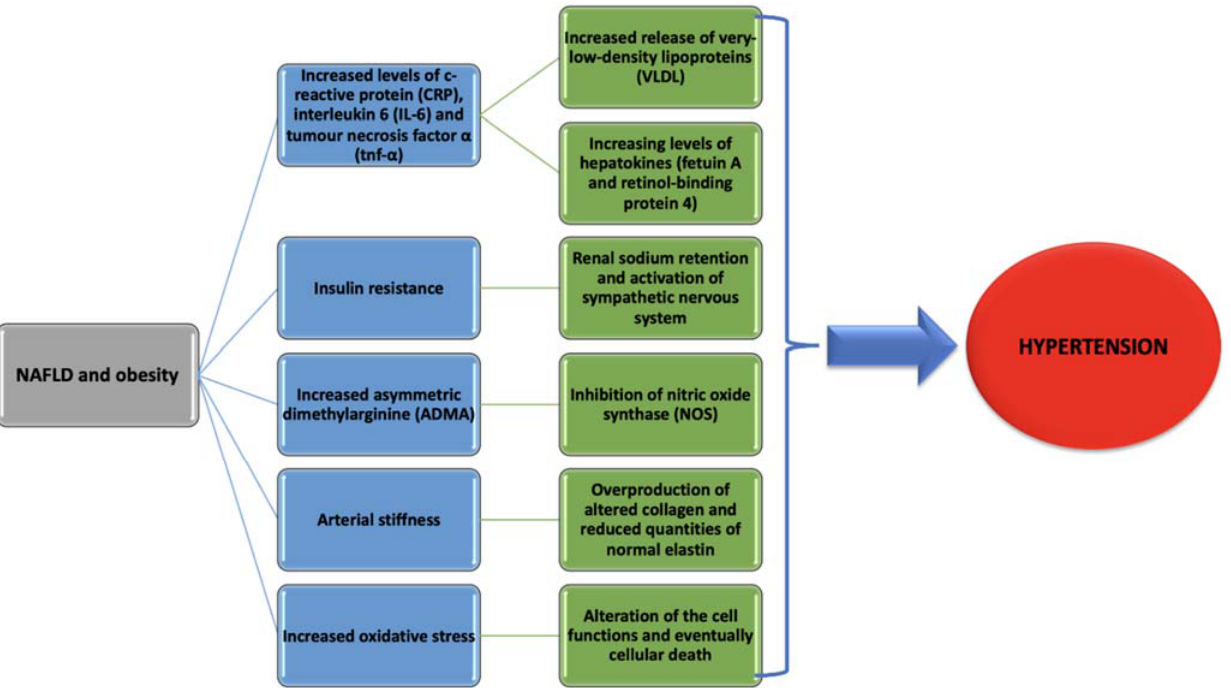
Figure 1. Pathogenic mechanisms behind hypertension development in non-alcoholic fatty liver disease (NAFLD) and obesity.